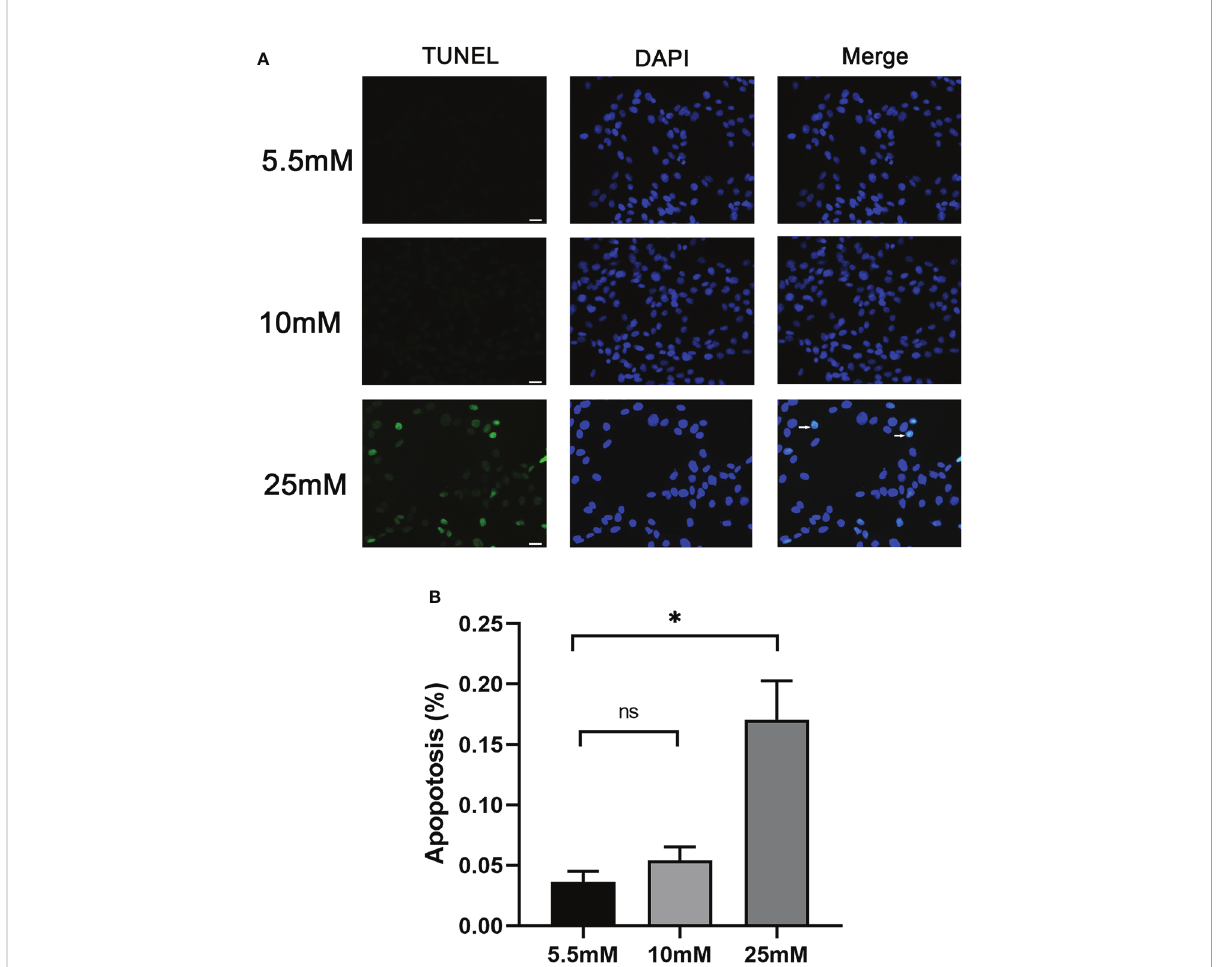
FIGURE 2 Podocyte apoptosis was detected by TUNEL staining with different glucose concentrations. (A) Podocyte apoptosis rate increased signi fi cantly in response to high glucose (25 mM). White arrows point to TUNEL-positive podocytes (apoptotic podocytes); magni fi cation: ×200; scale bar = 25 m m. (B) Absolute count of TUNEL-positive podocytes. Data were expressed as the mean numbers of apoptotic podocytes from 20 randomly selected fi elds and were from at least three independent experiments. Data are presented as mean ± SEM; * P < 0.05; ns, not signi fi